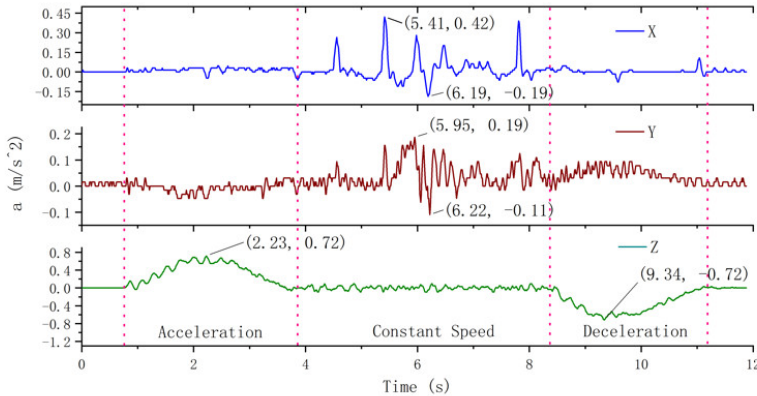
Figure 5. Vibration of the platform frame.